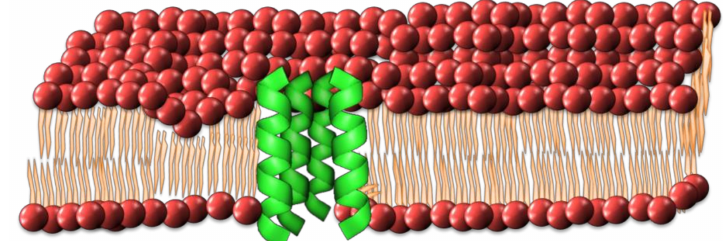
Figure 2. Schematic of how individual peptides might form the barrel-stave pore configuration in a cell